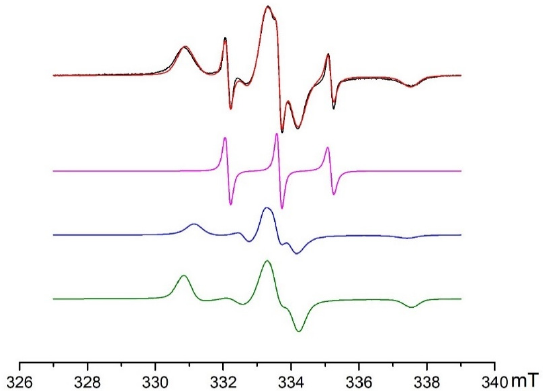
Figure 3. Experimental (black curve) and simulated (red curve) EPR spectra of the NR on the surface of the TiO 2 (7%)–SiO 2 binary system at pH ext = 5.58. The simulated EPR spectrum of the NR is a superposition of three signals, namely, fast-motioned NR ( magenta curve ), slow-motioned NR in the protonated ( blue curve ), and non-protonated forms ( green curve ). EPR titration curves of the NR in external aqueous solution, as well as in SiO 2 and the isotropic hyperfine splitting constant (HFS) was plotted vs. the pH ext . The fraction of the slow-motion component of NR inside the pores was determined via EPR spectra sim- ulation, and was used as a pH-dependent parameter for the investigation of SiO 2 and bi- nary TiO 2 –SiO 2 xerogels. The upper part of the titration curve for the SiO 2 sample was found to be shifted to the right (to the higher pH ext values), relatively to the EPR titration curves of the NR in external aqueous solution (the black curve), which indicated a negative charge of the sili- con dioxide surface in a neutral and weakly acidic solution (at pH ext > 3–4) [30,33]. As the value of pH ext decreased, the EPR titration curve for this oxide came closer to the calibra- tion curve and intersected it, thus shifting to the left, relatively to that at a pH ext less than three. It is known that the hydroxylated silica surface has point of zero charges ( PZC ) at pH ext values between two and three, and becomes charged positively at the lesser value pH ext [34]. The horizontal plateaus in the titration curves of the NR inside SiO 2 , and the TiO 2 – SiO 2 binary xerogels obtained by simulating the anisotropic spectra, reflected the invari- ance of the fraction of the non-protonated form of the NR, f , with a change in pH ext . These plateaus were explained by the ionization of the silicon dioxide silanol groups [33]. The pKa values of functional groups can be measured by projecting any pH-sensitive parame- ter of an EPR spectrum of the NR inside the material corresponding to a horizontal plateau on the calibration curve, and then to the pH ext axis [33]. In our case, the pH-sensitive pa- rameter was f (Figure 4) .